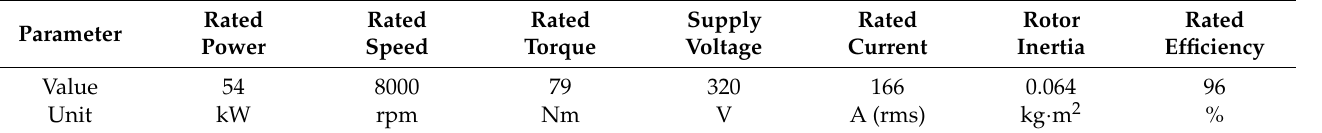
Table 5. Electric motor parameters.